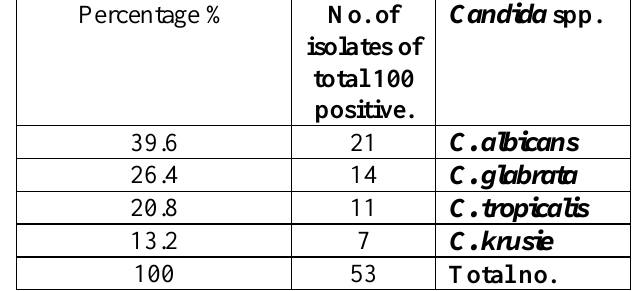
Figure 4. Colonies of Candida spp. On HiCrome Candida Differential medium .(a): Candida albicans, (b): Candida krusie , (c)candida glabrata , (d) candida tropicalis Table 1 Candida spp. percentage isolated from patients on chromogenic medium .